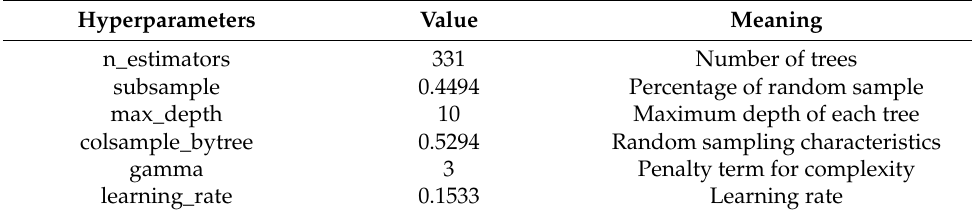
Figure 3. TPE optimization process. Table 3. Hyper-parameters of XGBoost.